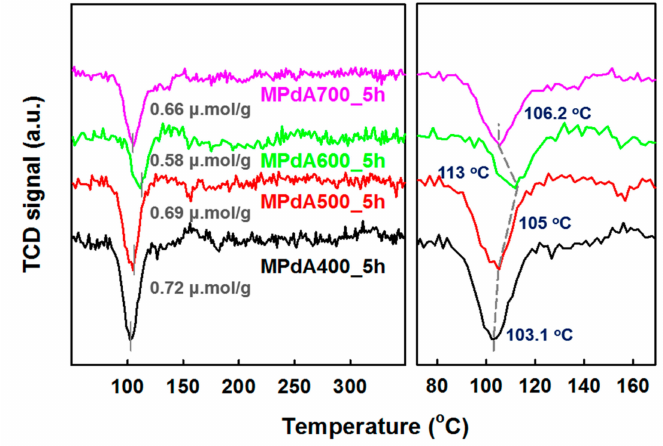
Figure 3. H 2 -TPR profiles of the MPdA catalysts calcined at di ff erent temperatures for 5